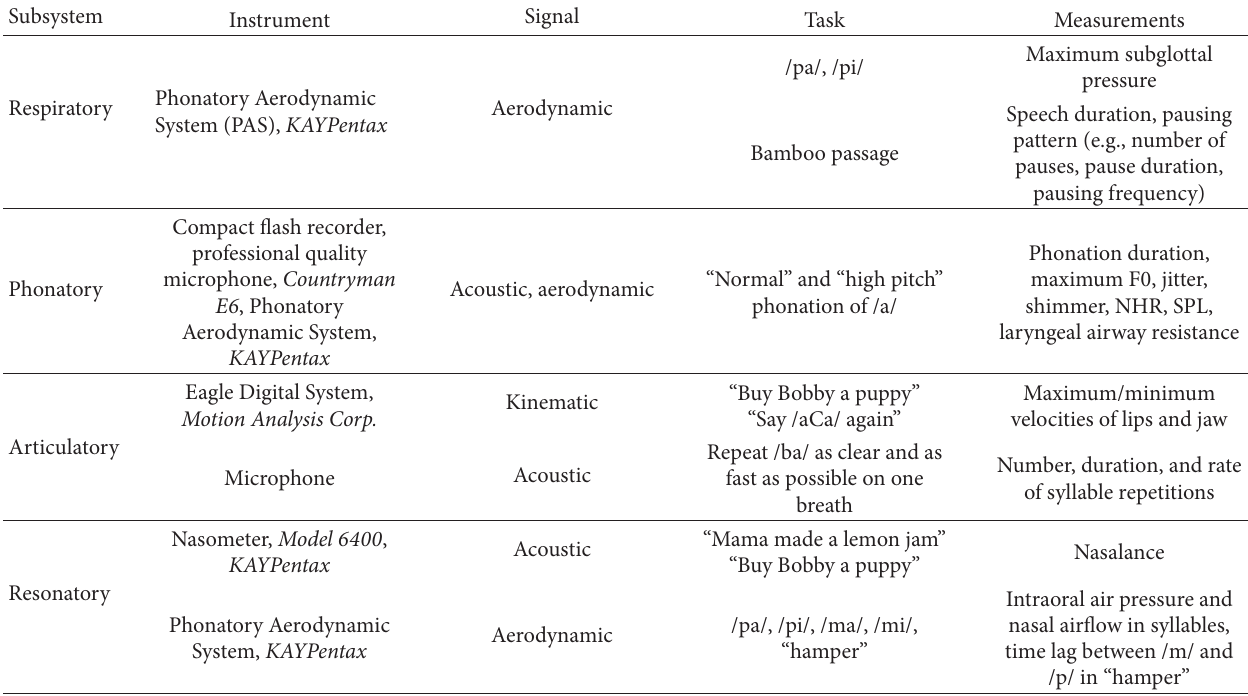
Table 3: Instrumentation and data acquisition settings for measurements of speech subsystem